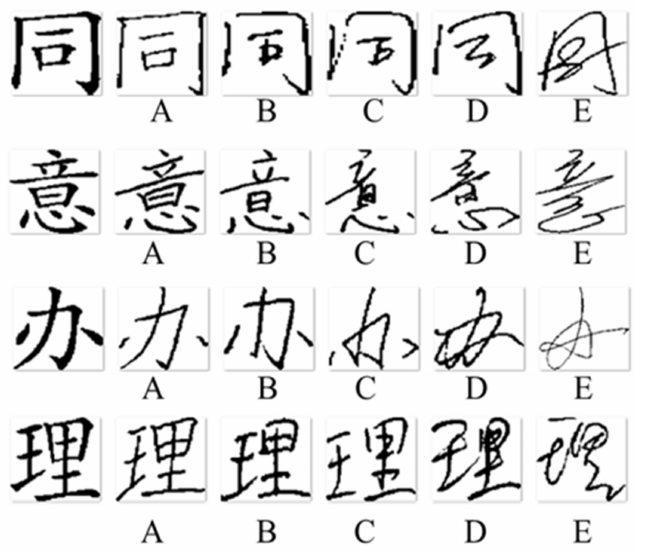
Figure 2. The images of Chinese characters “ 同 ”, “ 意 ”, “ 办 ”, and “ 理 ” (means “agree to proceed”) written by five different persons labeled with A, B, C, D, and E in five normative levels and their Song typeface counterparts (the first column).